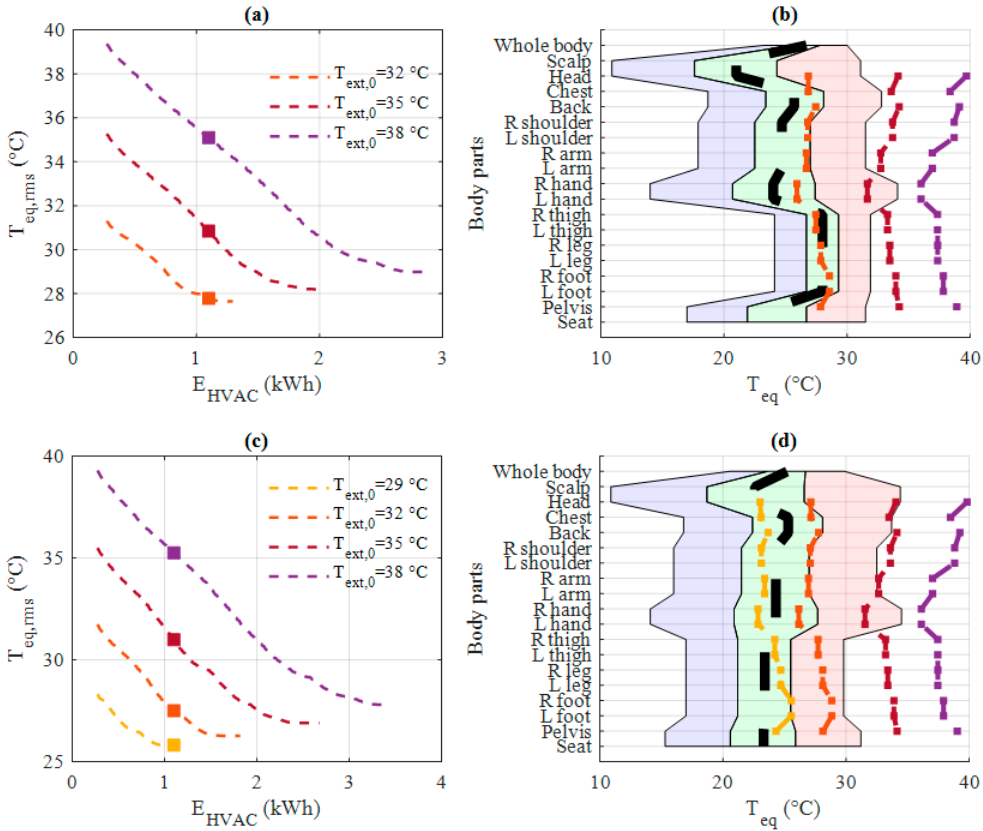
Figure 14. Pareto frontiers and the mean local equivalent temperatures for different outside temperature profiles, for a driver dressed in: ( a , b ) informal way, ( c , d ) formal way. In this harsh scenario, all (cid:1846) (cid:3032)(cid:3044),(cid:3036) lie outside the comfort zone, which means that the driver experiences an uncomfortable hot thermal sensation in the last 15 min of the trip. The same conclusions can be formulated in the case of the driver dressed in a formal way (Figures 14c,d). As stated before, the algorithm takes actions on the HVAC system in order to choose the optimal thermal comfort for a given available energy. Hence, it is worth analyzing these actions and their consequences on the cabin physical quantities and the driver’s thermo-physiological responses. Figure 15 shows the temporal evolution of cabin temperature and relative humidity that corresponds to colored squares plotted in Figure 14c. The yellow cabin temperature profile has the ideal shape since it leads to an ideal comfort. First, the cabin temperature drops at the beginning of the trip, when the hot cabin needs to be cooled down. This phase cannot be reduced below a certain time due to thermal inertia and the maximum power of the HVAC system. The temperature decreases afterwards until reaching 22 °C, which is the comfort temperature at (cid:1869)(cid:4662) (cid:3046)(cid:3048)(cid:3041) = 1000 W/m (cid:2870) (Table 3) For an outside temperature (cid:1846) (cid:3032)(cid:3051)(cid:3047),(cid:2868) = 32 °C , the available energy is not sufficient to maintain ideal comfort over the whole trip. In this situation, after the cooling phase, the cabin temperature is maintained around 23.7 °C for 20 min, then it increases slowly until reaching 26 °C at the end of the trip. For even higher (cid:1846) (cid:3032)(cid:3051)(cid:3047),(cid:2868) , the temperature at final time can reach 34 °C. Figure 15 shows also the temporal evolution of two HVAC control variables: the compressor rotation speed (Figure 15c) and the air flow (Figure 15d). The compressor speed is set at its maximum value during the cooling phase, then it is adjusted according to the available energy, in order to provide the “reachable” thermal comfort.